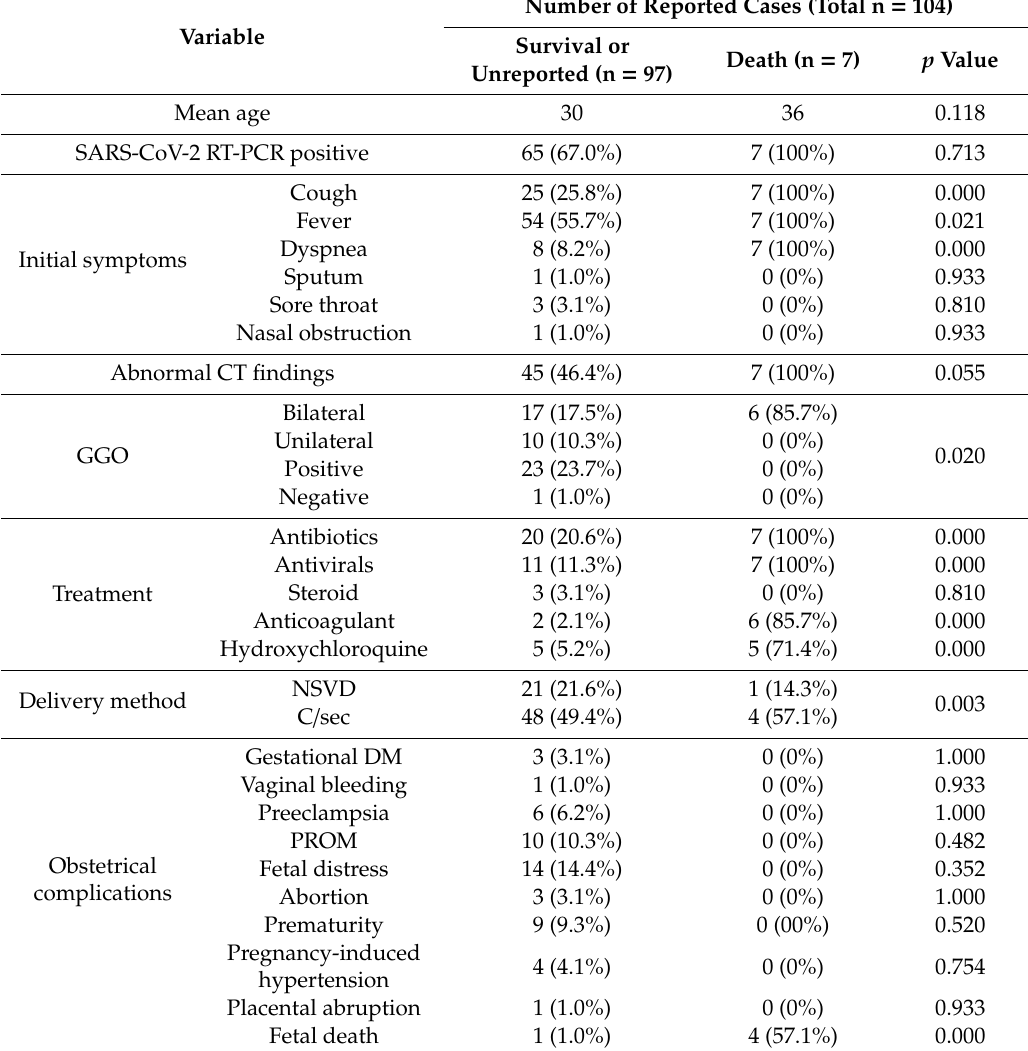
Table 7. Evaluation of clinical characteristics on maternal